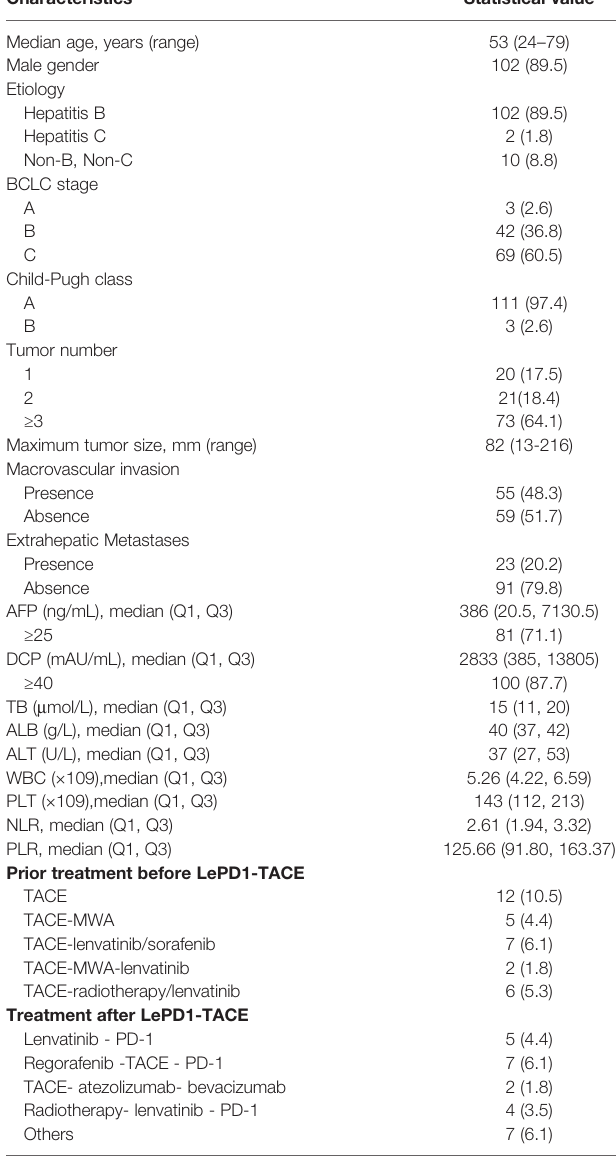
TABLE 1 | Baseline characteristics of the 114